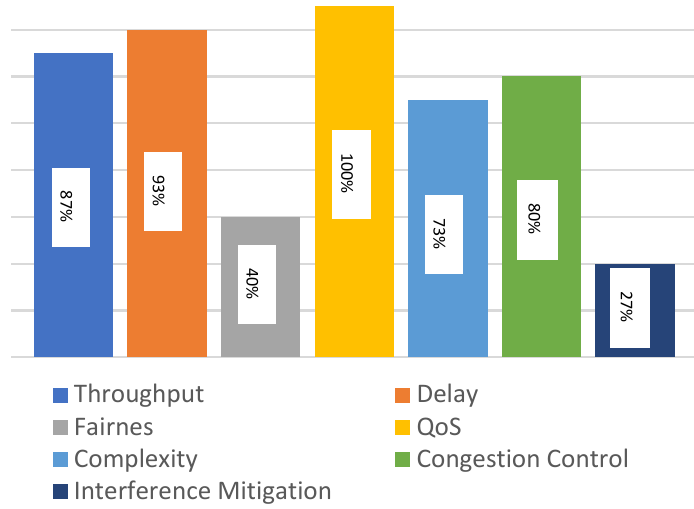
Figure 6. Percentage of load balancing metrics from sampled papers as illustrated by Table 3.